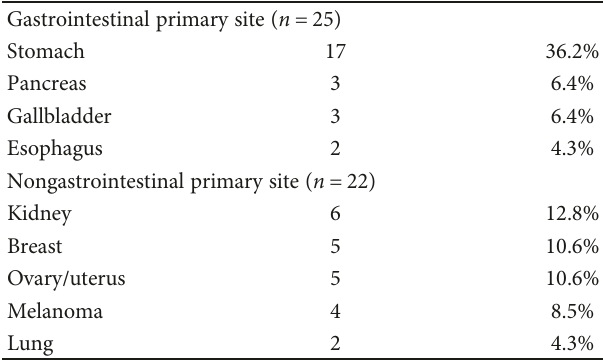
Table 2: Primary tumor histology.